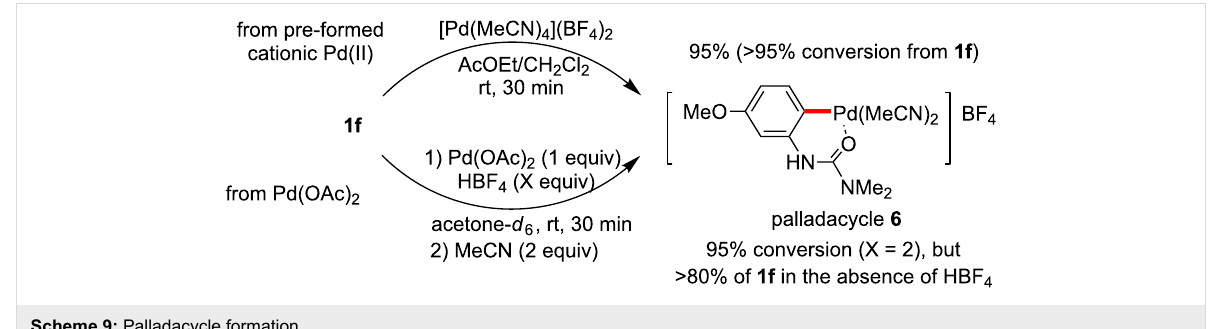
Scheme 9: Palladacycle formation.